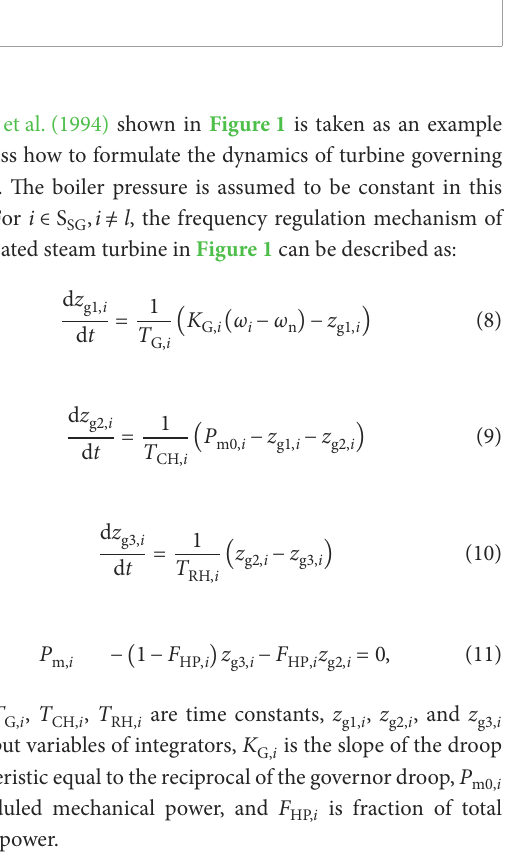
FIGURE 1 Block diagram of a reheated steam